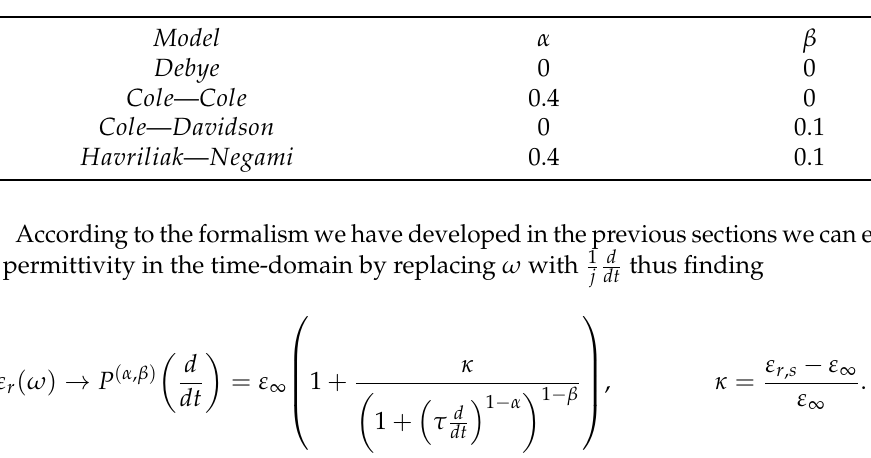
Table 1. Dielectric